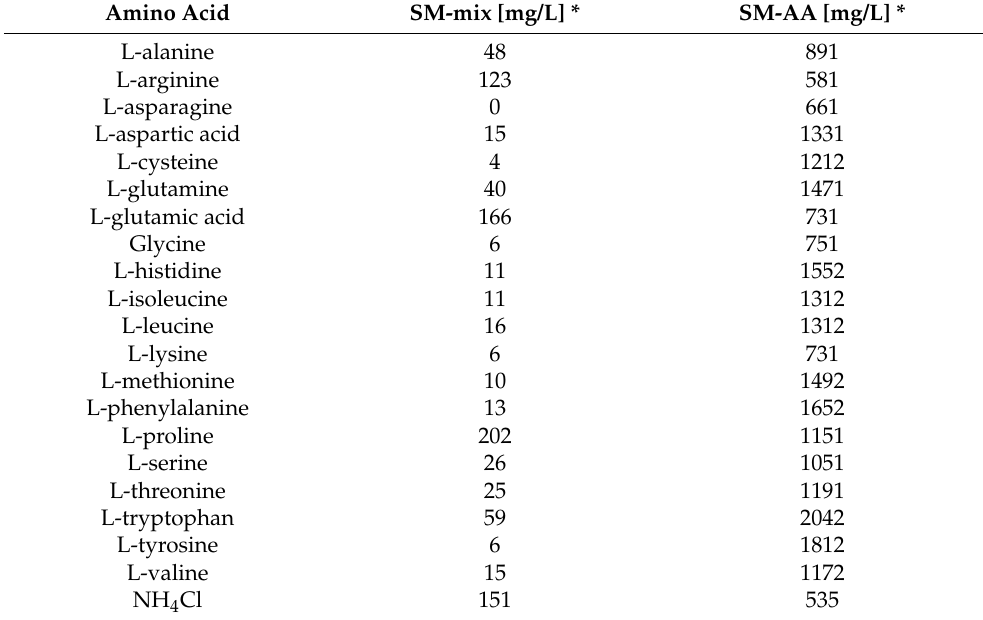
Table 3. Amino acid and ammonium concentrations of the synthetic must with amino acid mix (SM-mix) and when used individually in the single amino acid fermentations (SM-AA). Amino Acid SM-mix [mg/L] * SM-AA [mg/L] *